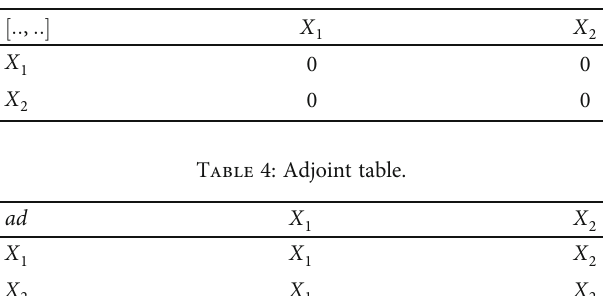
Table 3: Commutator table.